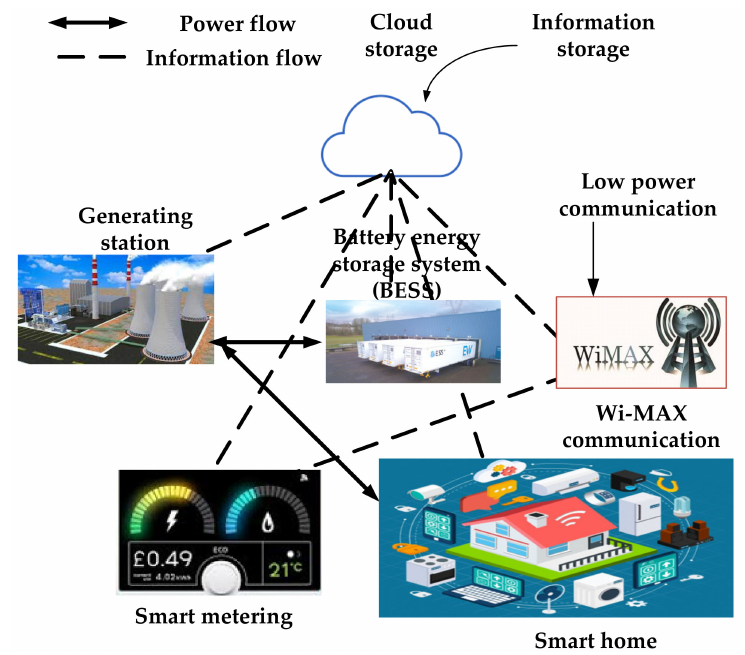
Figure 13. A detailed communication framework for effective